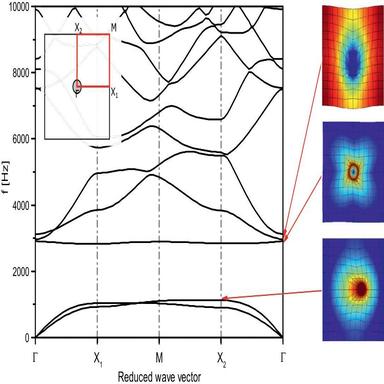
Dispersion curves of the melamine-aluminum metamaterial in the first Brillouin zone, which is illustrated in the upper left corner of the graph.